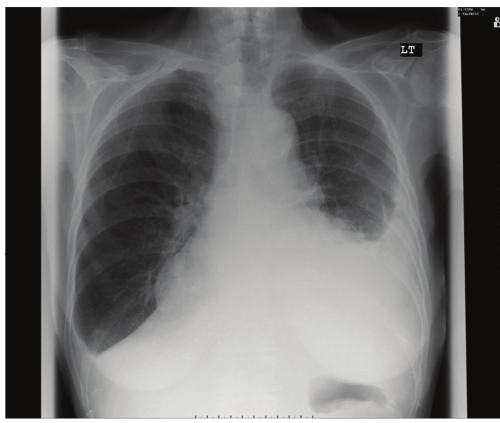
Figure 1: Pleural e ff usion while being on carbimazole.